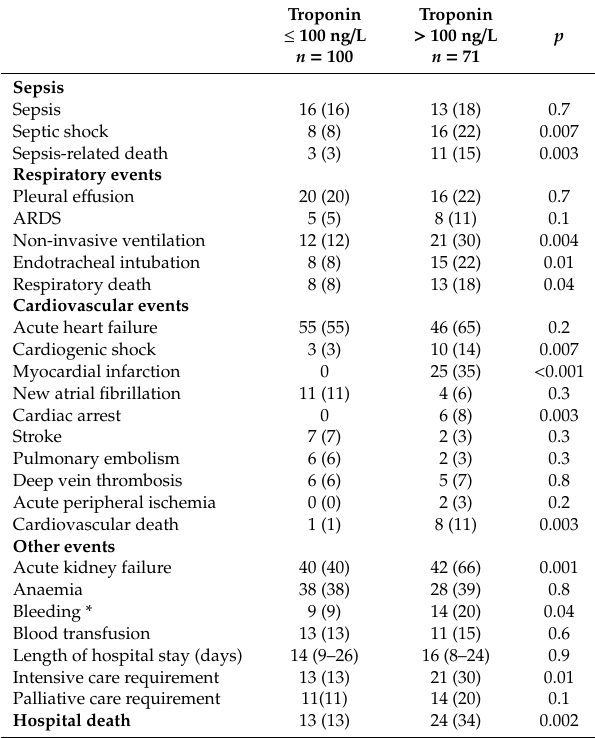
Table 3. In-hospital outcomes after acute pneumonia in older inpatients ( n (%) or median (interquartile